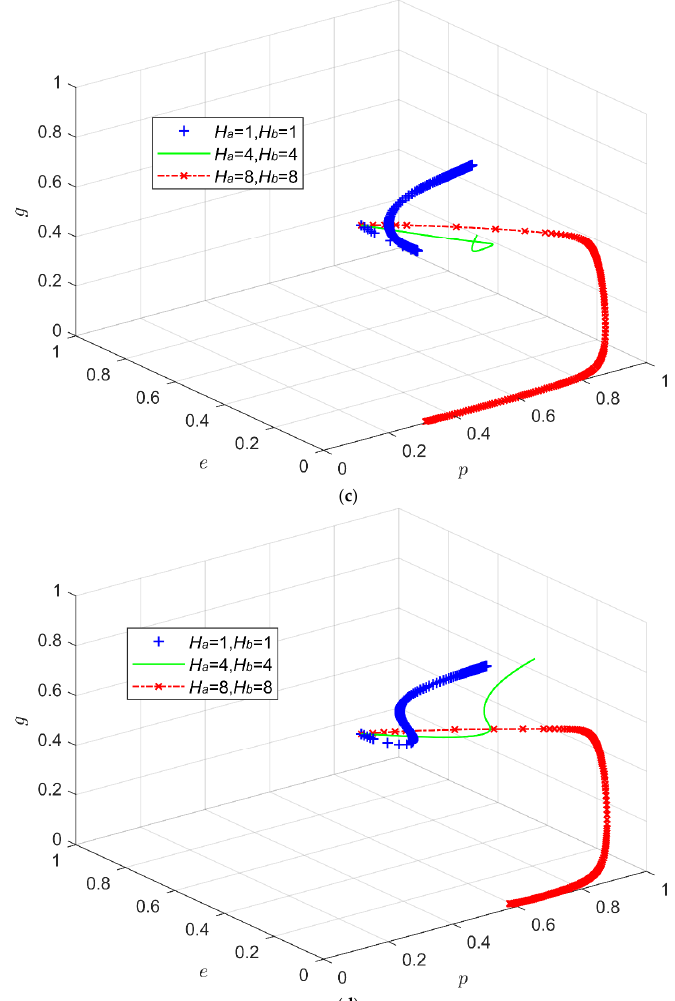
Figure 3. ( a ) Influence of quality improvement returns on system evolution under static reward and static penalty systems. ( b ) Influence of quality improvement returns on system evolution under dynamic reward and static penalty systems. ( c ) Influence of quality improvement returns on system evolution under static reward and dynamic penalty system. ( d ) Influence of quality improvement returns on system evolution under dynamic reward and dynamic penalty systems.